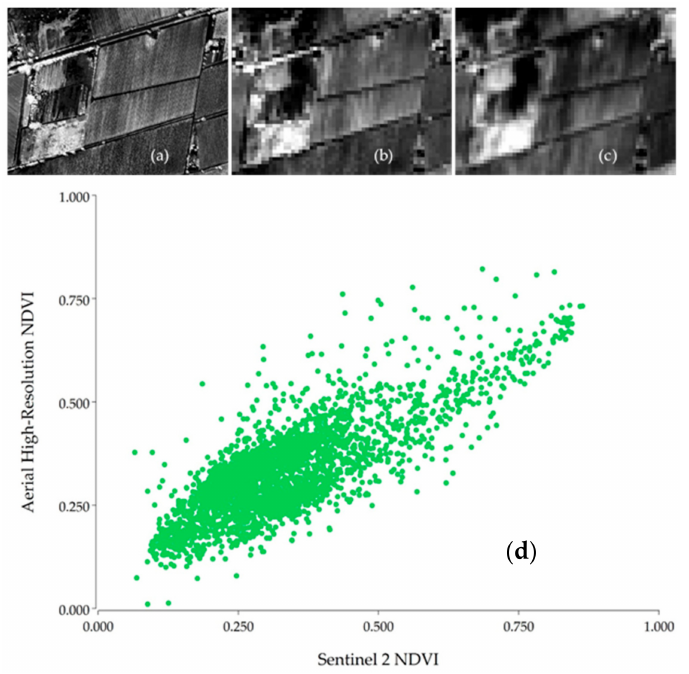
Figure 3. ( a ) Aerial 0.07 m resolution Normalized Difference Vegetation Index (NDVI) image of a vineyard in the Valle de Uco, Mendoza, taken the on January 22nd, 2020. ( b ) Aerial image with 0.07 m pixels aggregated to 10 m resolution. ( c ) Sentinel 2 Level 2 NDVI 10 m resolution image of the same date. ( d ) Scatterplot of Sentinel 2 vs. aggregated aerial